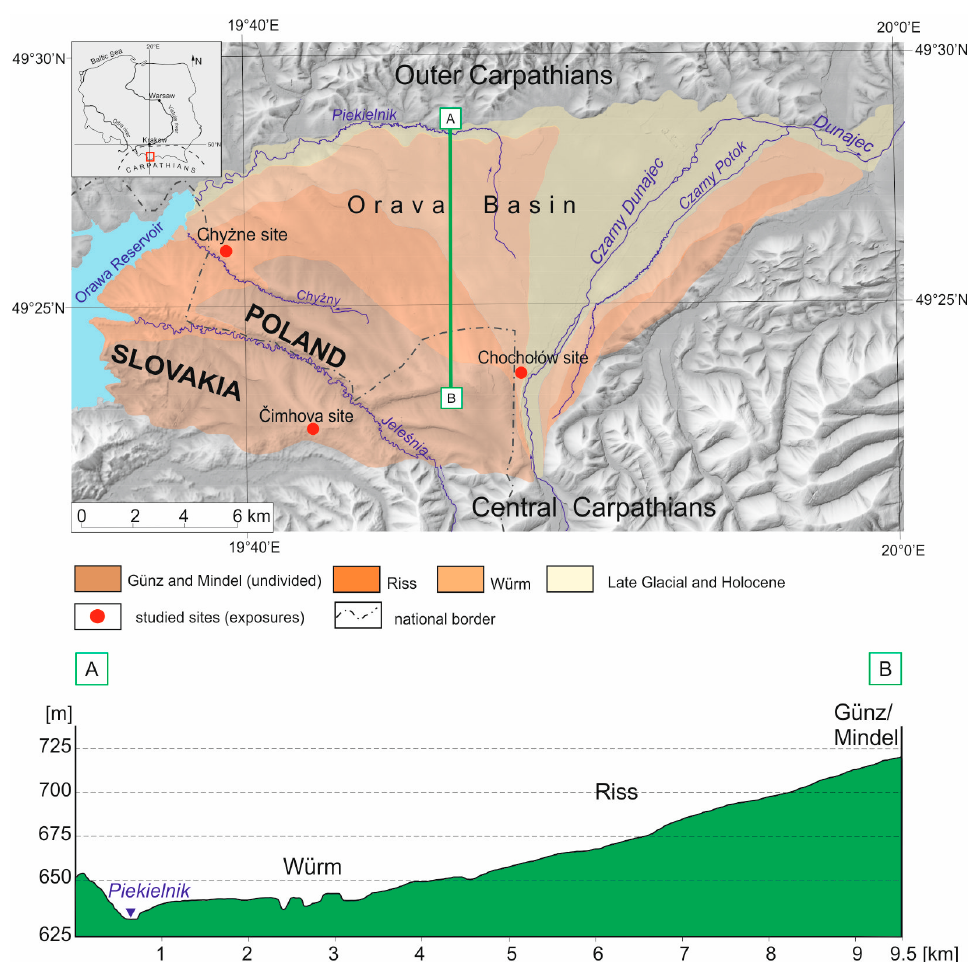
Figure 1. Sediment sampling location and cross-section through the glaciofluvial fans of the Czarny Dunajec River in the Orava Basin (age and extent of fans after Watycha [22,23], Baumgart-Kotarba [25], and Chmielowska and Woronko [33]).